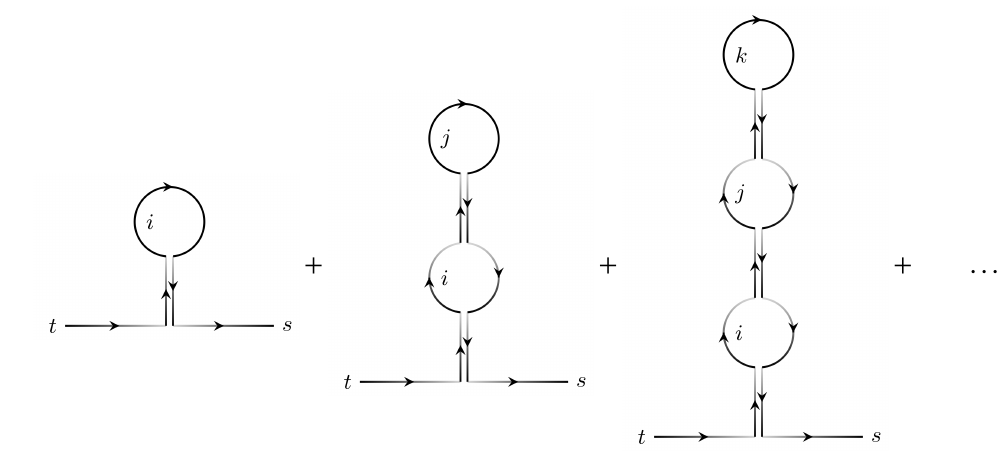
Figure 1: The leading correction to the MFT result is due to an infinite series of O ( 1 ) cactus diagrams; here, we have illustrated those arising to first order in the expansion of tanh, i.e., φ ( h ) ≈ h . Each pair of vertices contributes a combined factor of 1 / N , which is cancelled by a complementary factor of N from the sum over an internal neuron index, labelled by i , j , k